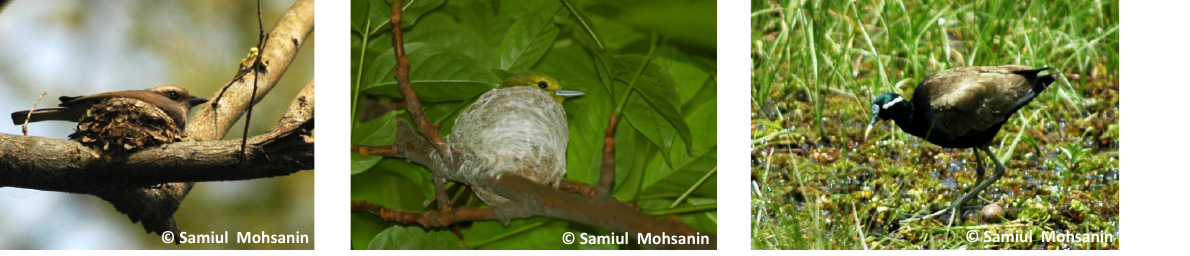
Image 13. Common Woodshrike